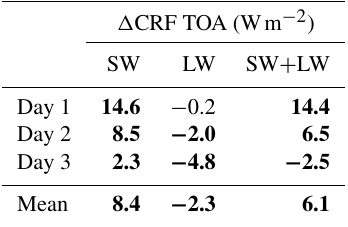
Table 3. Diurnal-average changes in cloud radiative forcings ( (cid:49) CRF; in Wm − 2 ) for the overlying absorbing aerosol case rela- tive to the lightly drizzling baseline case ( N a , sulfate = 150mg − 1 ). Conventions as in Table 2.